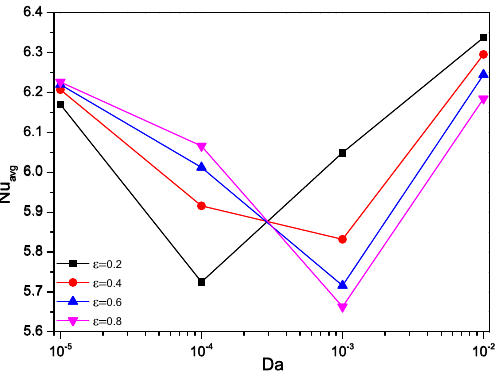
Figure 15. Variations of Nu avg with Da for diverse ε when Ra = 10 6 , ω = 0 , φ = 0.02 , N = 4 , r = 0.1 and Ha = 0 .